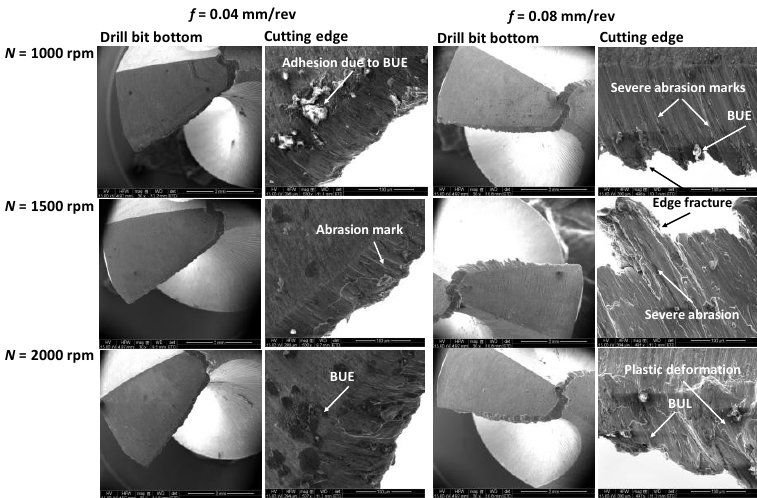
Figure 5. SEM images of the drill-bit bottom and their magnified view of the cutting edge after 10th Figure 5. Scanning electron microscope (SEM) images of the drill-bit bottom and their magnified view hole for different spindle speed and feedrate. of the cutting edge after 10th hole for different spindle speed and